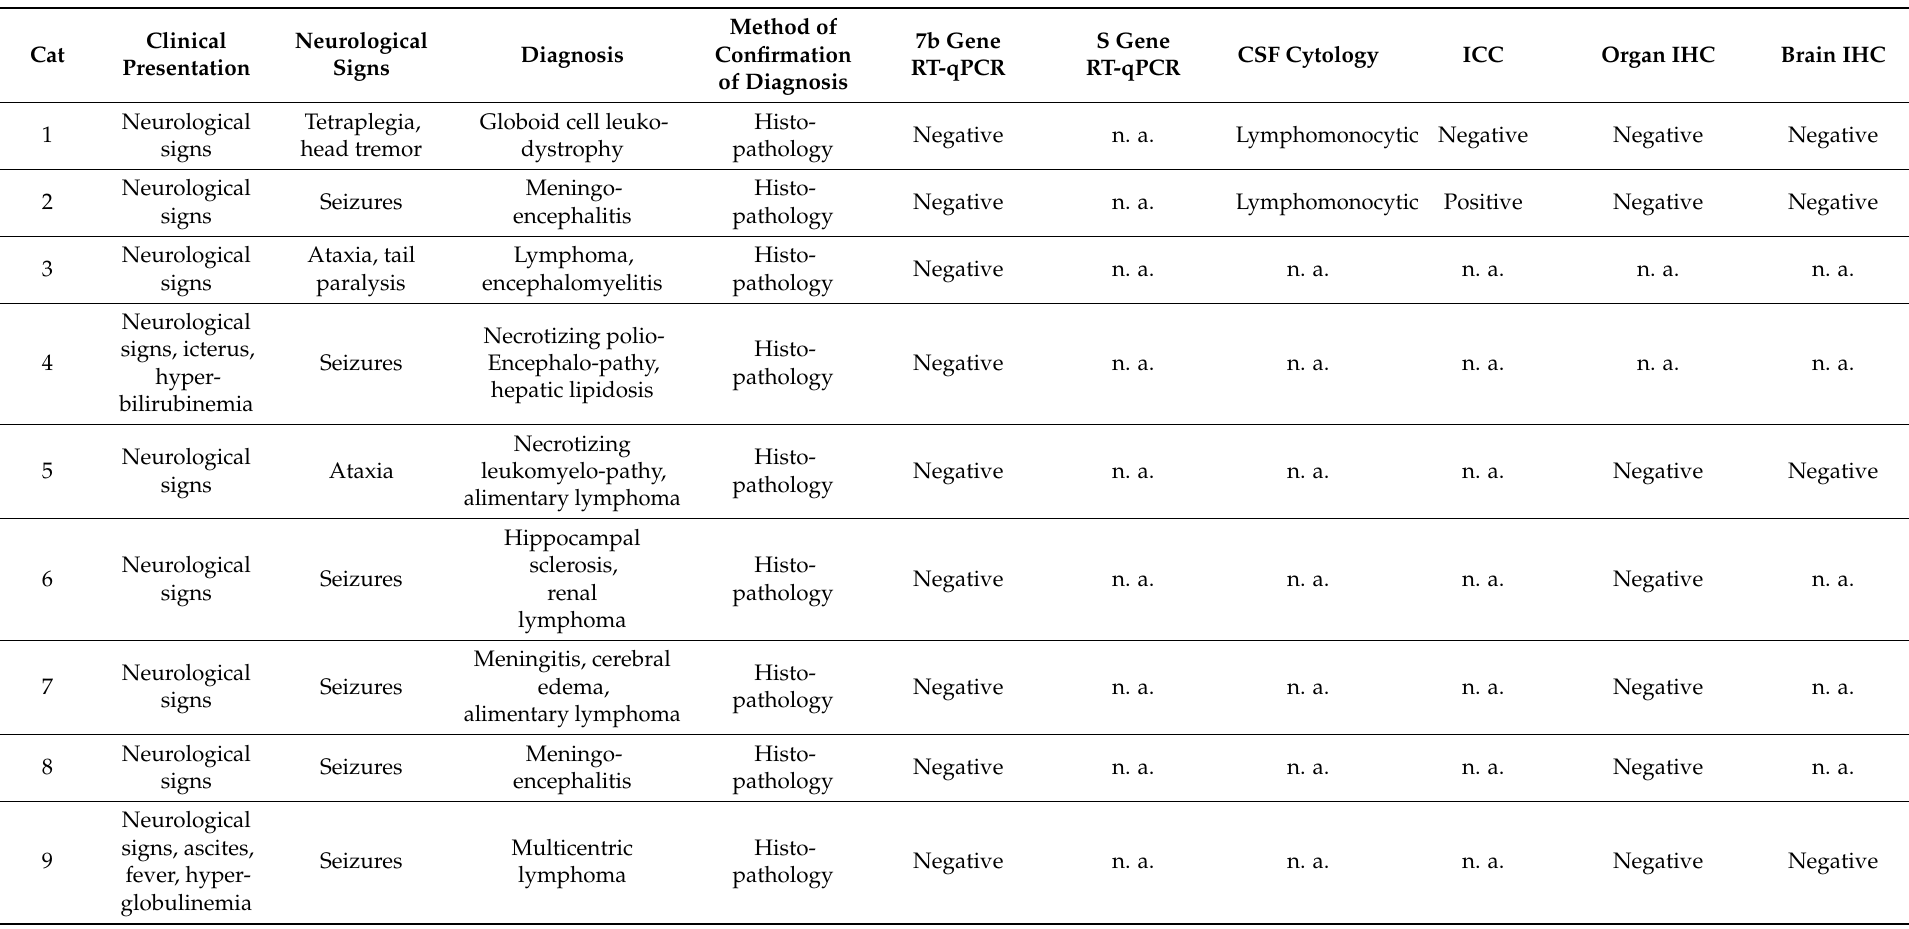
Table 2. Details of control cats: clinical and/or laboratory signs upon presentation leading to inclusion, details of neurological signs, if present, final diagnosis and method of confirmation, results of the 7b and spike (S) gene realtime reverse transcriptase polymerase chain reactions (RT-qPCR), results of cerebrospinal fluid (CSF) cytology, immunocytochemistry (ICC), and immunohistochemistry (IHC) of affected organs and the brain, if